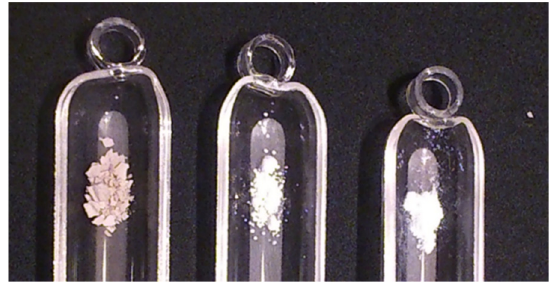
Figure 5. Samples of magnesium oxide obtained by calcination at 873 K of the three precipitates of magnesium hydroxide; 1st, 2nd and 3rd precipitation in sequence from left to right.